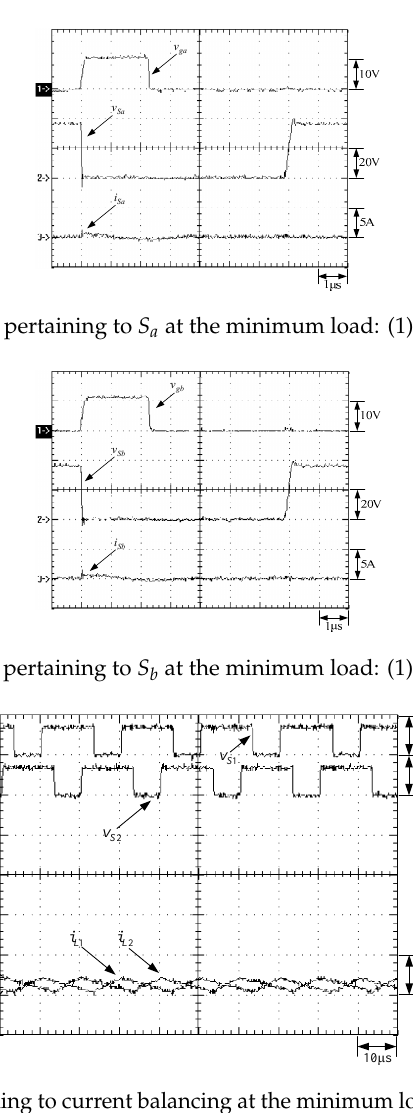
Figure 23. Waveforms pertaining to current balancing at the minimum load: (1) v S 1 ; (2) v S 2 ; (3) i L 1 ; and (4) i L 2 .